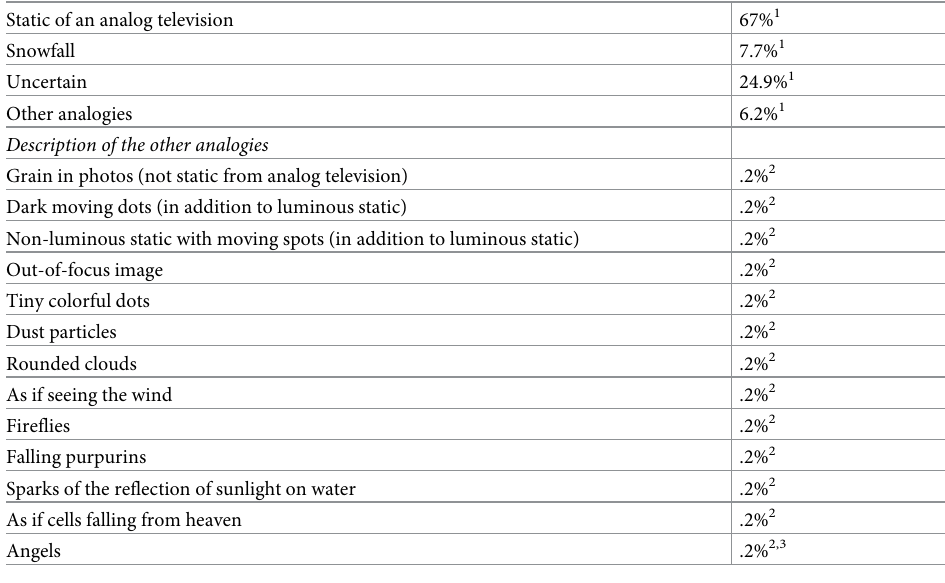
Table 3. Analogies of visual snow (Study 1; N =